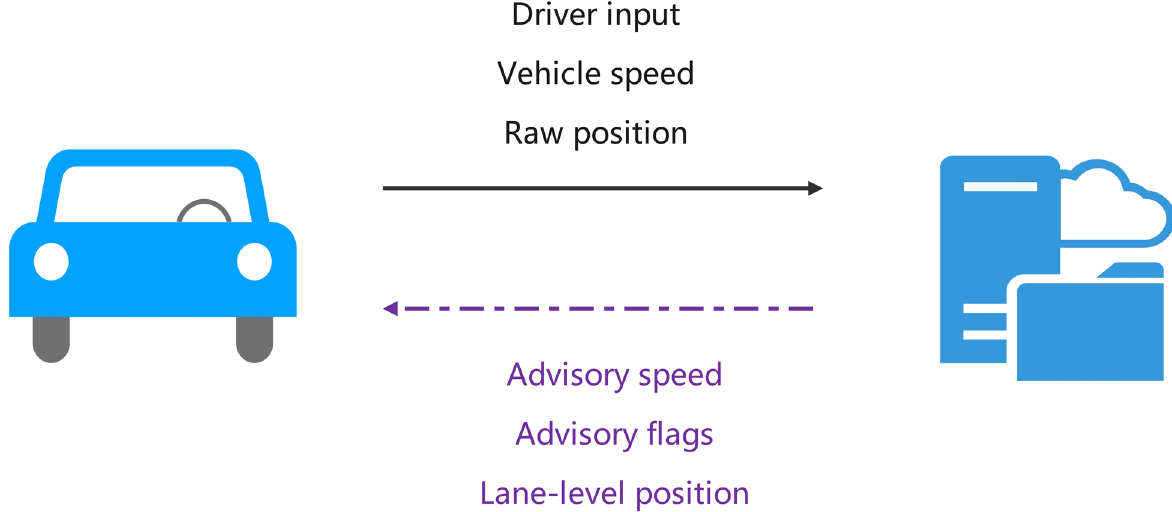
Fig. 2 Cloud-Edge (RSU and OBU) communication scenarios in